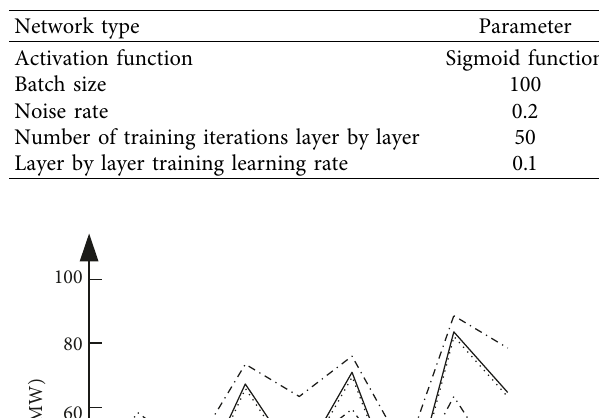
Table 1: Model parameters of the stacked noise reduction auto- matic encoder.